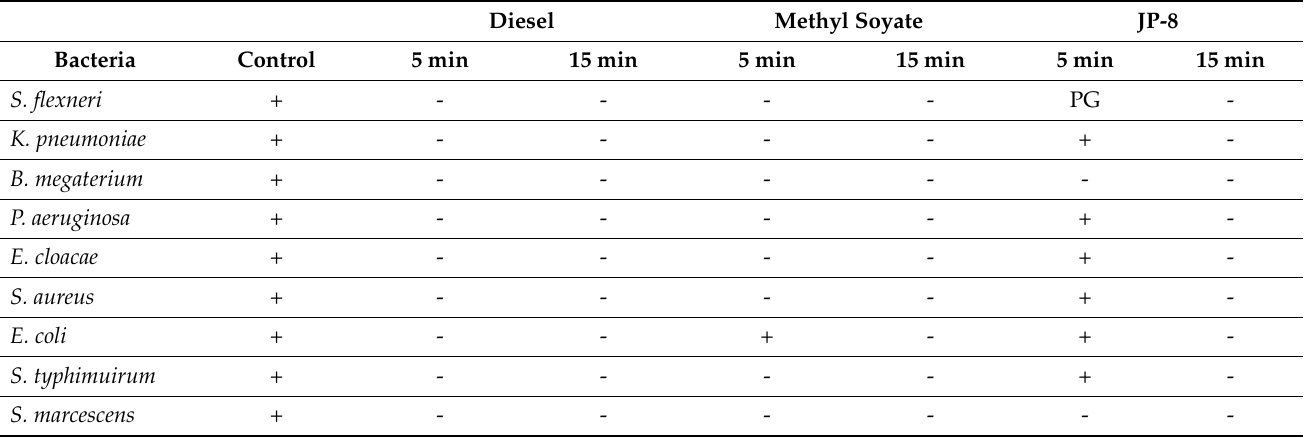
Table 12. Relative antimicrobial activity of oil aerosols produced from methyl soyate and other